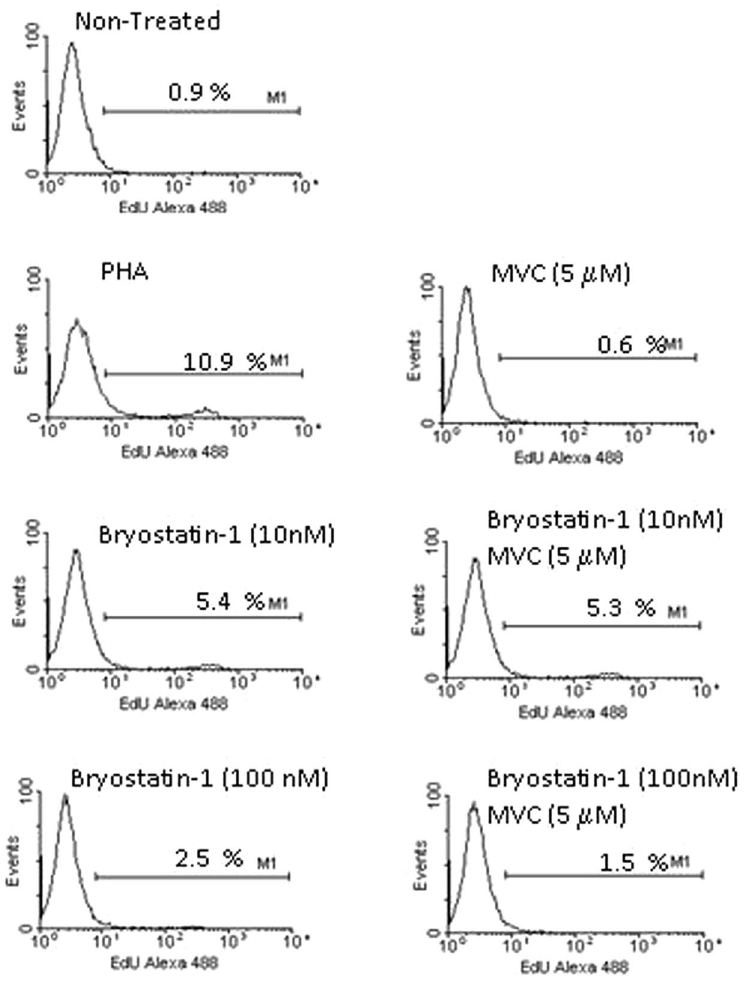
Figure 4. Analysis of cell proliferation in rCD4 + T treated with MVC alone or in combination with Bryostatin-1. Primary rCD4 + T cells were left untreated or treated with MVC (5 μ M) alone or in combination with Bryostatin-1 (10 nM or 100 nM) for 18 h. Non-treated cells were used as a negative control. Stimulation with PMA for 18 h was used as positive control. Cell proliferation was measured by quantifying the percentage of DNA-synthesizing cells. Data shown are cytometry histogram of FL-1 channel fluorescence. Numbers indicate the percentage of proliferating cells. A representative experiment is